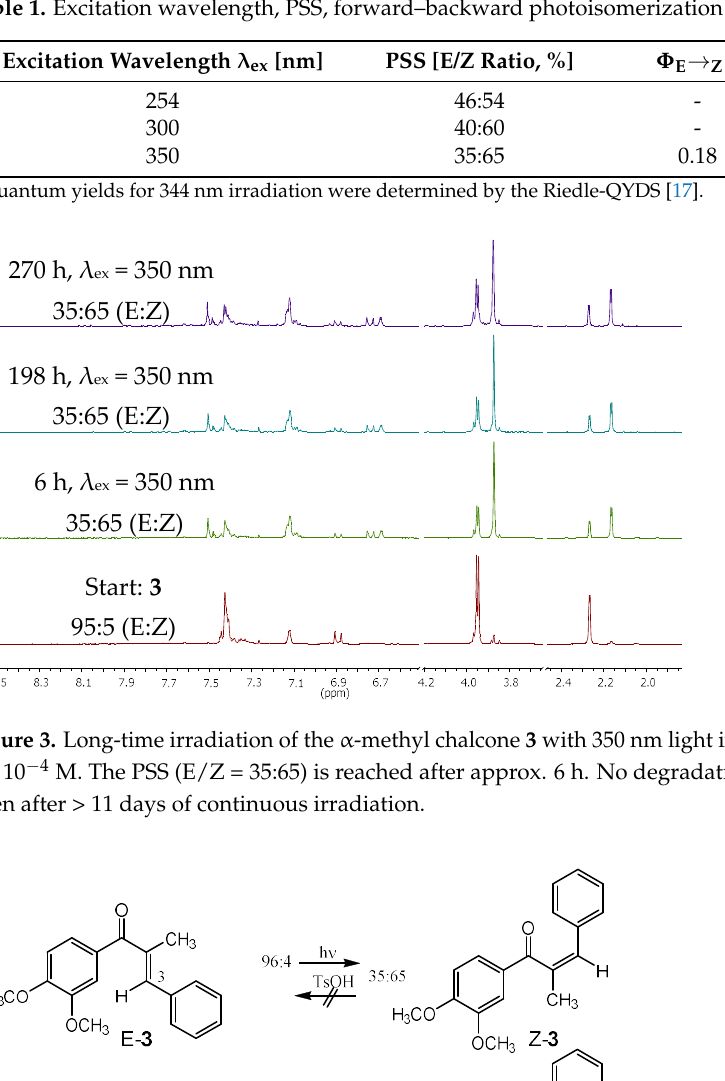
Figure 2. Irradiation at 350 nm of a 10 −5 M solution of the α-methyl chalcone 3 in acetonitrile solu- tions. The photostationary equilibrium (E/Z = 35:65) is reached is less than 1 min. Negative photo- nm.